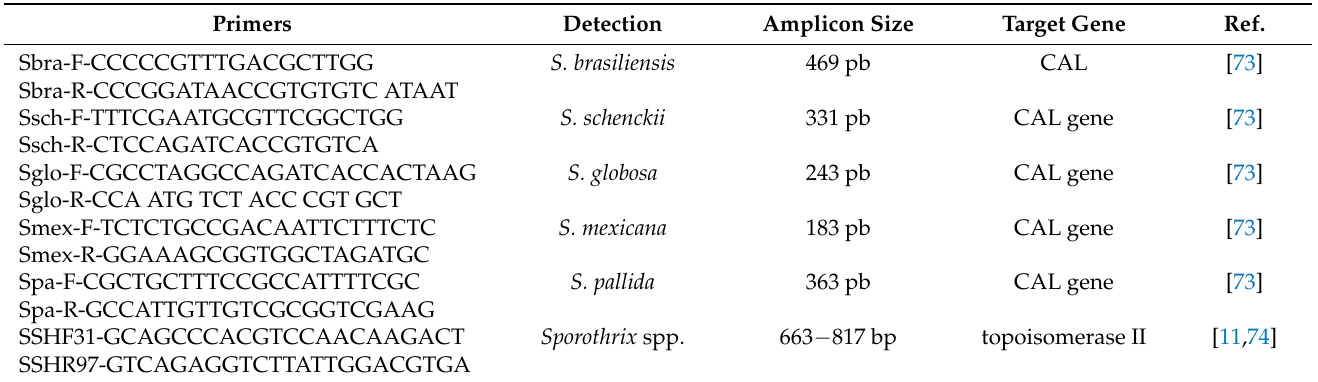
Table 4. Primer sequences and amplicon sizes for the detection of Sporothrix species and Sporothrix spp by conventional